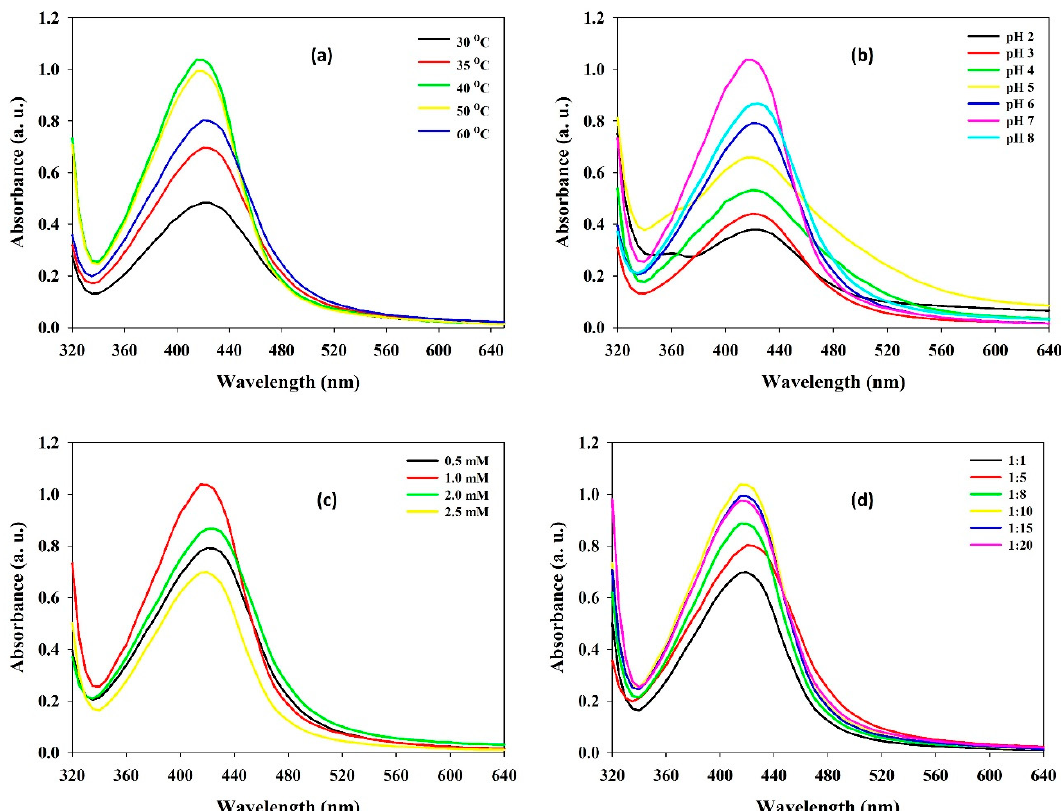
Figure 4. The effect of various influencing operational parameters ( a ) incubation temperature; ( b ) initial pH; ( c ) AgNO 3 concentration; and ( d ) Ta:AgNO 3 ratio on the synthesis of Ta-AgNPs and their UV-visible spectra.